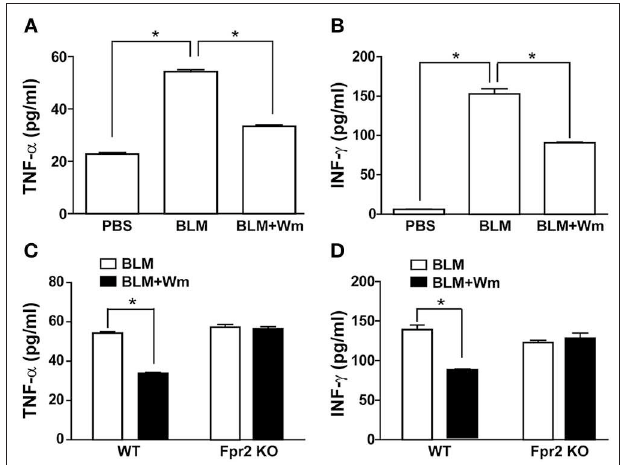
FIGURE 8 | The role of Fpr2 in WKYMVm-induced immune resolution in scleroderma. (A,B) Wm-induced inhibition of systemic inflammation in scleroderma. The BLM-induced scleroderma mice model were treated with or without Wm for 3 weeks, and the serum levels of TNF- α (A) and INF- γ (B) in the mock-treated (PBS) and the scleroderma mice (BLM or BLM + Wm) were determined by ELISA assay. (C,D) The role of Fpr2 in Wm-induced suppression of systemic inflammation in scleroderma. The BLM-induced scleroderma model of wild type and Fpr2 KO mice were daily injected with or without Wm for 3 weeks, and the serum levels of TNF- α (C) , and INF- γ (D) in the scleroderma mice were quantified by ELISA analysis. Data represent mean ± SD ( n = 8 per group). * p <